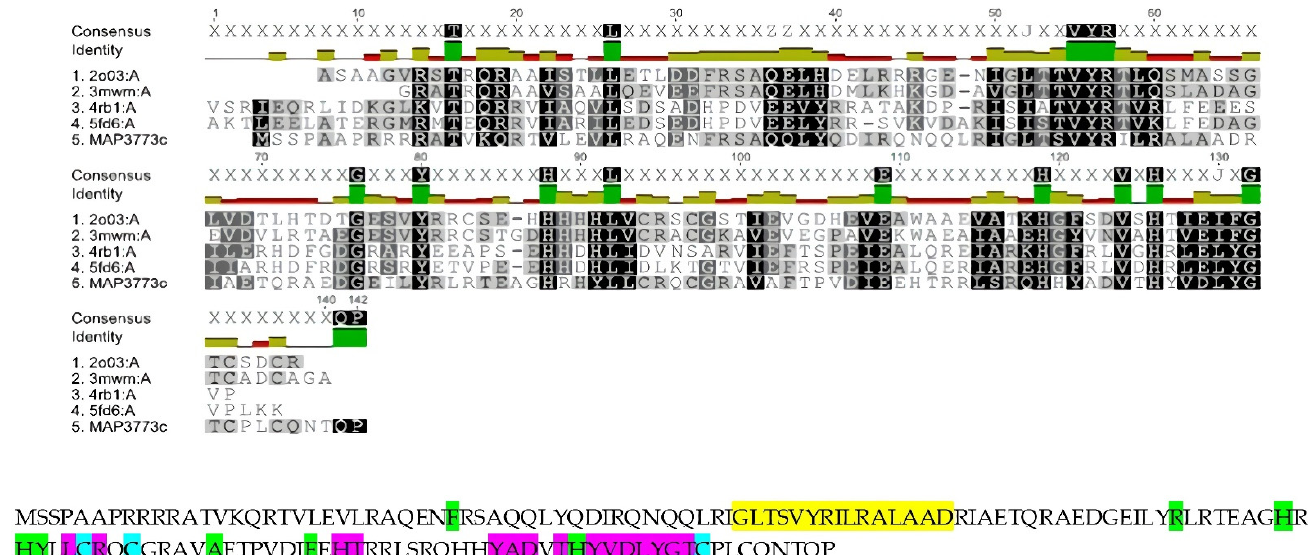
Figure 1. Sequence alignment of MAP3773c with FUR proteins with available structures that show the highest similarity and down, conserved protein domain, yellow: putative DNA binding helix, green: metal binding site 1 and 2, blue: structural Zn 2+ binding site, magenta: polypeptide binding